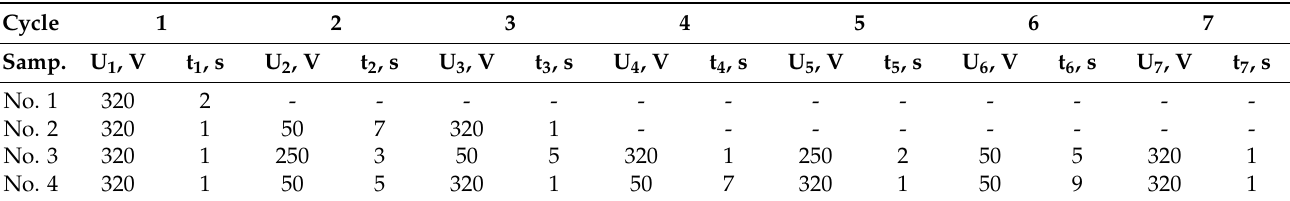
Figure 1. The process of processing the sample with electrolytic plasma ( a ) and the functional diagram of the installation ( b ): 1 — the workpiece; 2 — a cone-shaped electrolytic cell made of stainless steel; 3 — a pallet; 4 — a pump; 5 — a heat exchanger; 6 — a bath with electrolyte. Table 1. Technological parameters of the modes of EPTCH steel